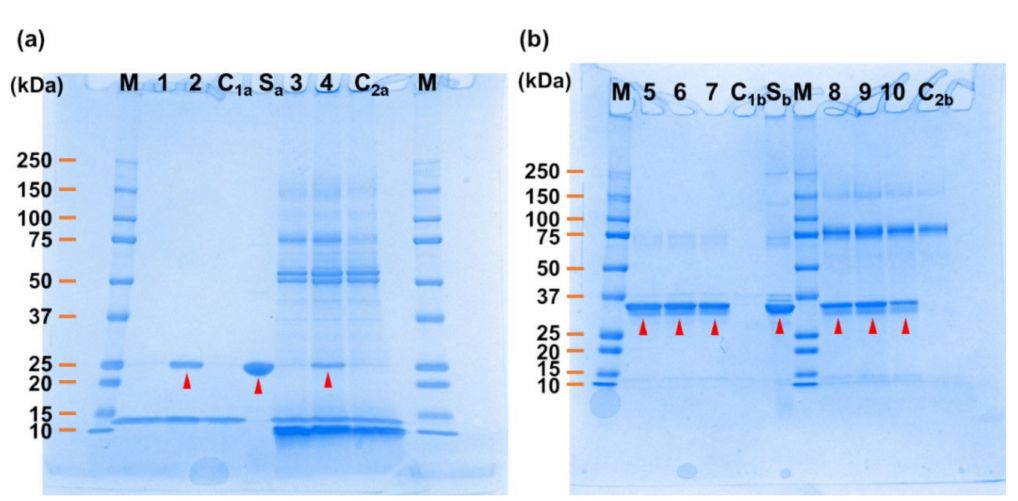
Figure 2. SDS-PAGE image of the samples, representative of the pull-down assay. ( a ) Pull-down assay using CRP in selection bu ff er (SB) or human saliva. Lane M: Precision Plus Protein Kaleido Scope Standards (Bio-Rad, United States); Lanes 1–2: CRP in SB sample eluted from the CRP–U gu2 and U gu4 -immobilizing CRP capture beads, respectively; Lane C 1a : CRP in SB bu ff er sample eluted from the control beads; Lane S a : CRP; Lanes 3–4: spiked CRP in human saliva sample eluted from the CRP– U gu2 and U gu4 -immobilizing CRP capture beads, respectively; Lane C 2a : spiked CRP in human saliva sample eluted from the control beads. ( b ) Pull-down assay using LDH-5 in SB or human saliva. Lane M: Precision Plus Protein Kaleido Scope Standards (Bio-Rad, United States); Lanes 5–7: LDH-5 in SB sample eluted from the LDH–U ad1 , U gu3 , and A ad1 -immobilizing LDH-5 capture beads, respectively; Lane C 1b : LDH-5 in SB bu ff er sample eluted from the control beads; Lane S b : LDH-5; Lanes 8–10: spiked LDH-5 in human saliva sample eluted from the LDH–U ad1 , U gu3 , and A ad1 -immobilizing LDH-5 capture beads, respectively; Lane C 2b : spiked LDH-5 in human saliva sample eluted from the control